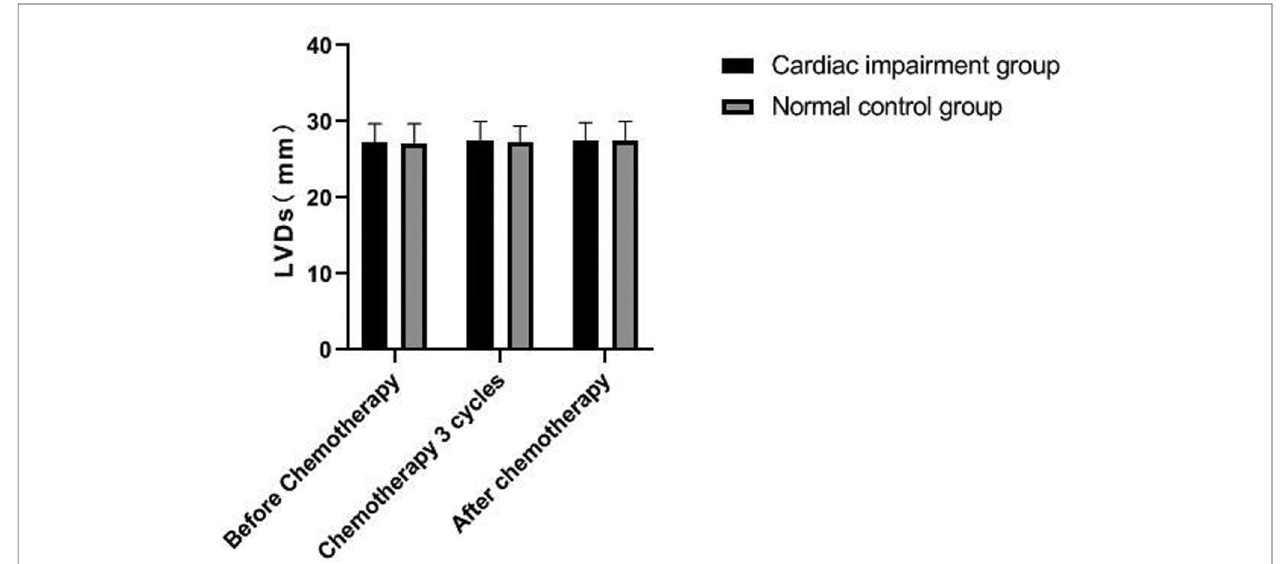
FIGURE 4 | Comparison of LVDs values between the two groups at different time points.